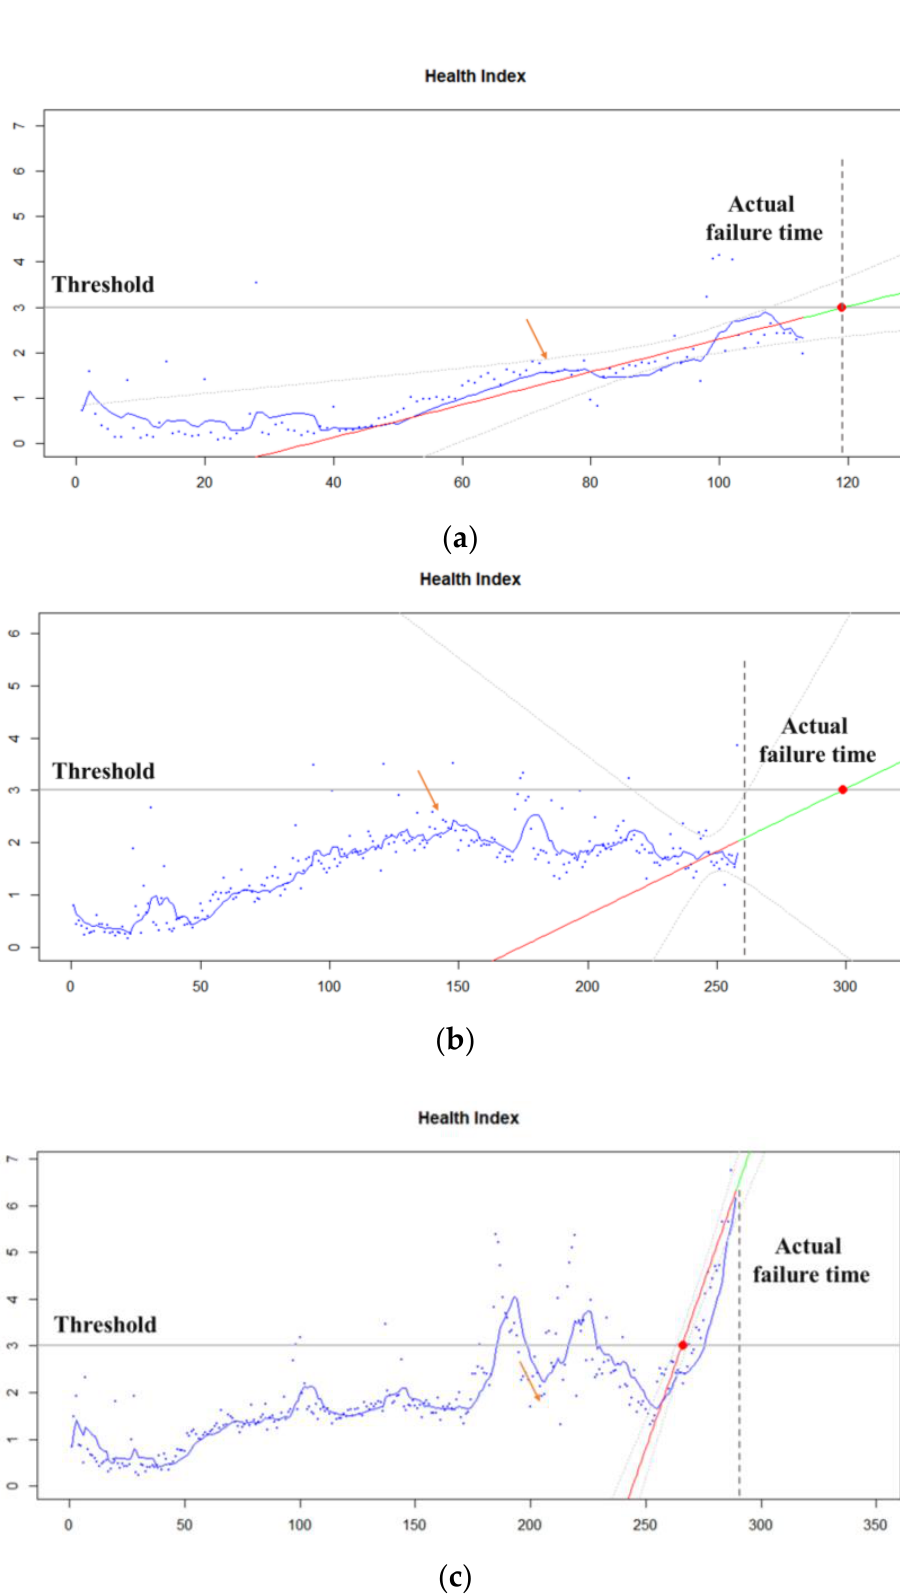
11 of 17 Figure 7. The variable plot of robot arm data. Table 1. The details of robot arm data. No. Size of Data (Time Span)